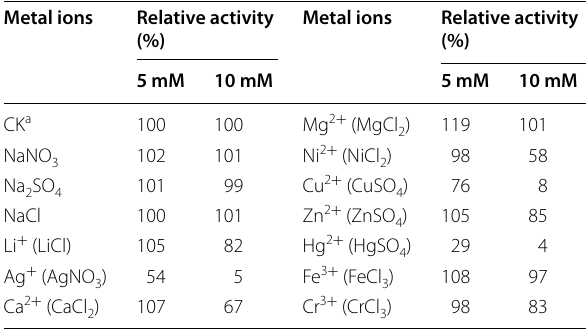
a The control check, which was not added with metal ions